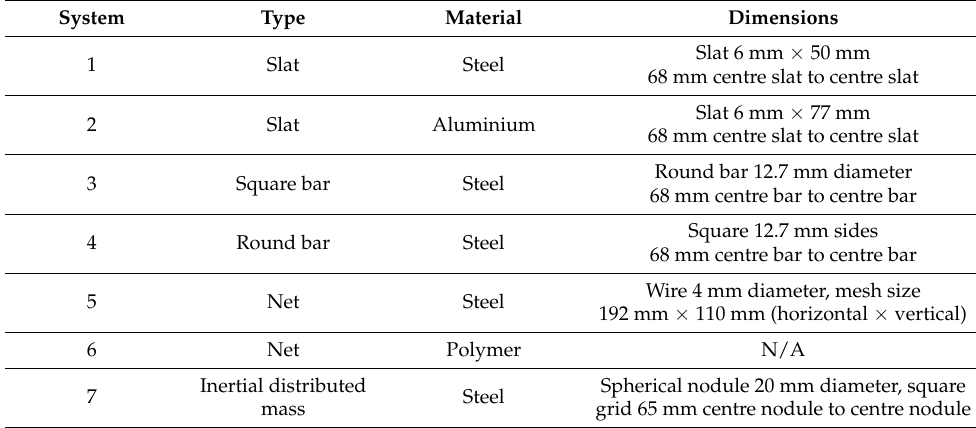
Table 6. Description of the considered cage armour systems.